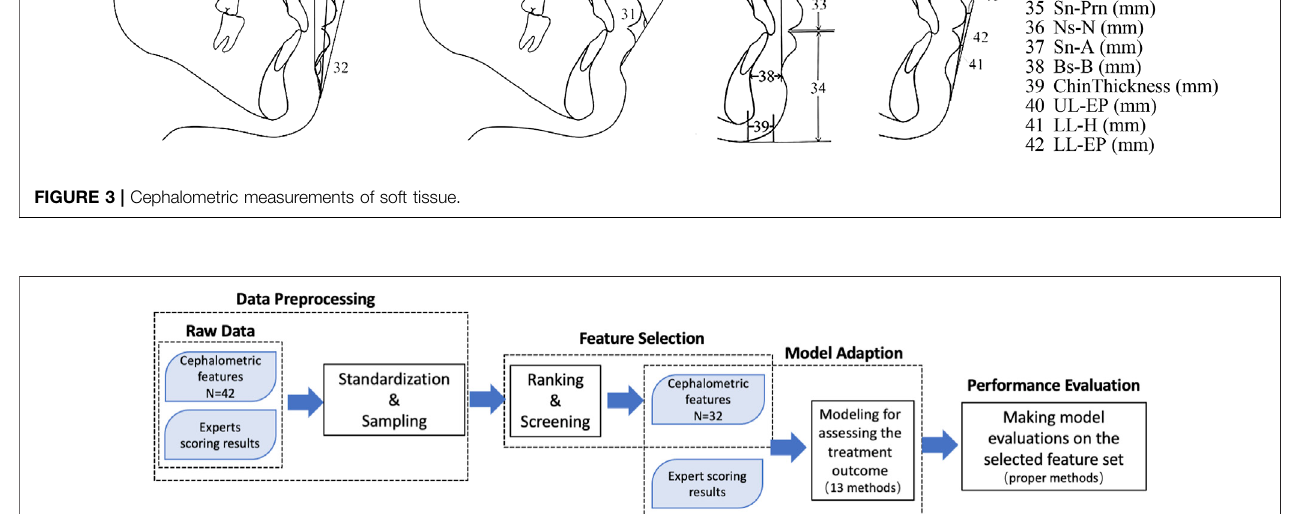
FIGURE 4 | Diagram of the process of analyzing the quantitative evaluation, which was performed by utilizing the cephalometric features as input data and the expert evaluation scores as output data.